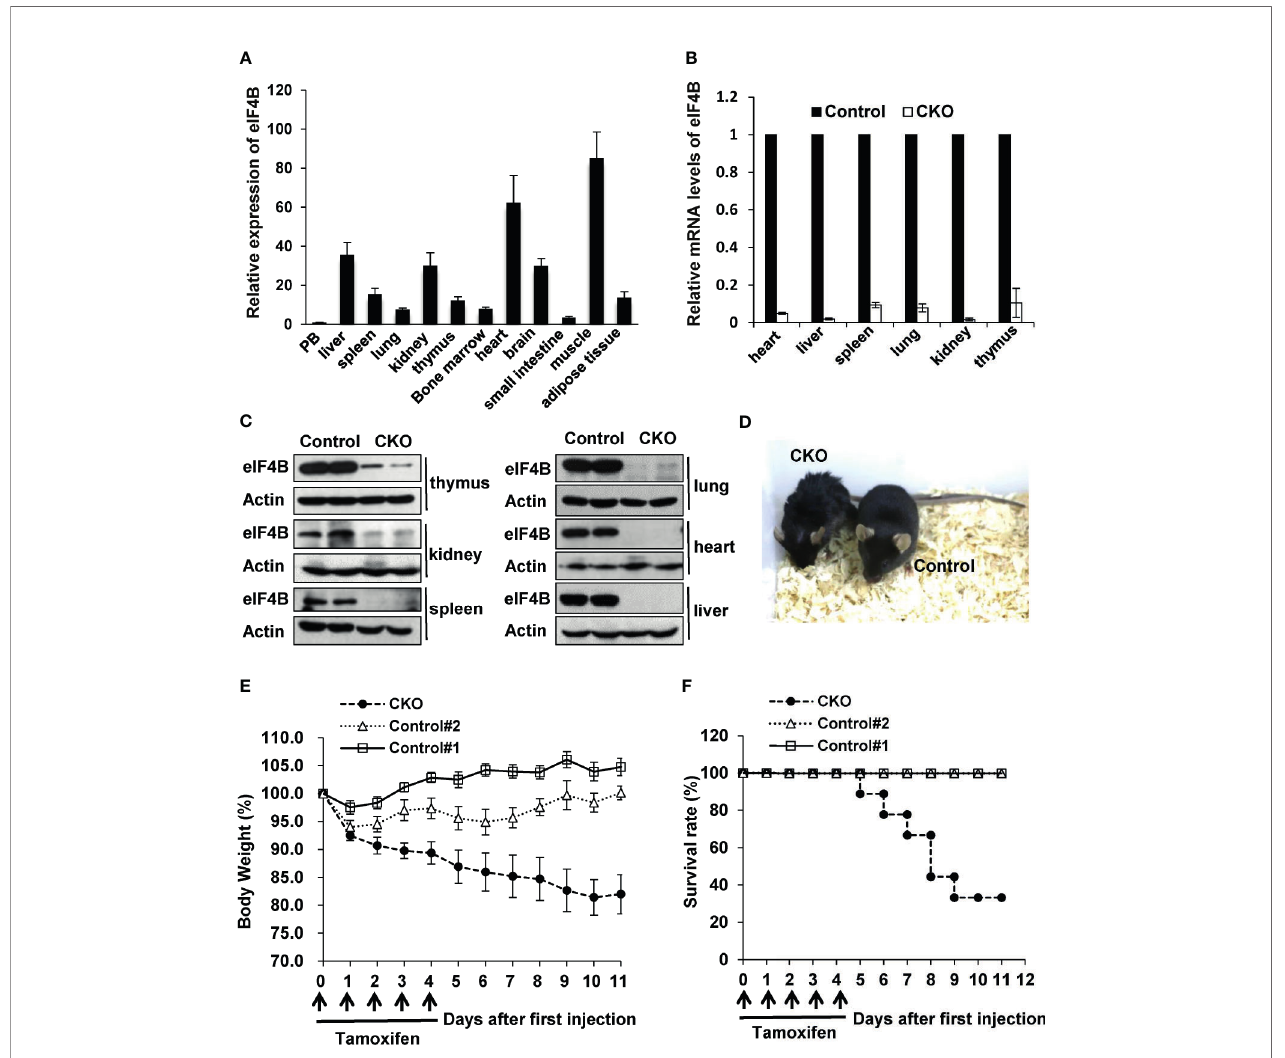
FIGURE 2 | Depletion of eIF4B markedly increases the mortality of adult mice. (A) Relative expression of eIF4B in different organs, was detected by qRT-PCR (n = 3). Data are represented as mean ± SD. (B, C) mRNA and protein levels of eIF4B in indicated tissues of eIF4B CKO mice and control littermates, were detected by qRT-PCR (B) and Western blotting (C) . (D) Shown is the representative photo of eIF4B CKO mice and control littermates treated with tamoxifen. (E, F) Shown are the body weight change (E) and survival rate (F) of eIF4B CKO mice and control littermates (8-10 mice per group). “ Control#1 ” represents “ eIF4B f/f , Cre + Corn oil ” group, “ Control#2 ” represents “ eIF4B f/f + Tamoxifen ” group, “ CKO ” represents “ eIF4B f/f , Cre + Tamoxifen ”